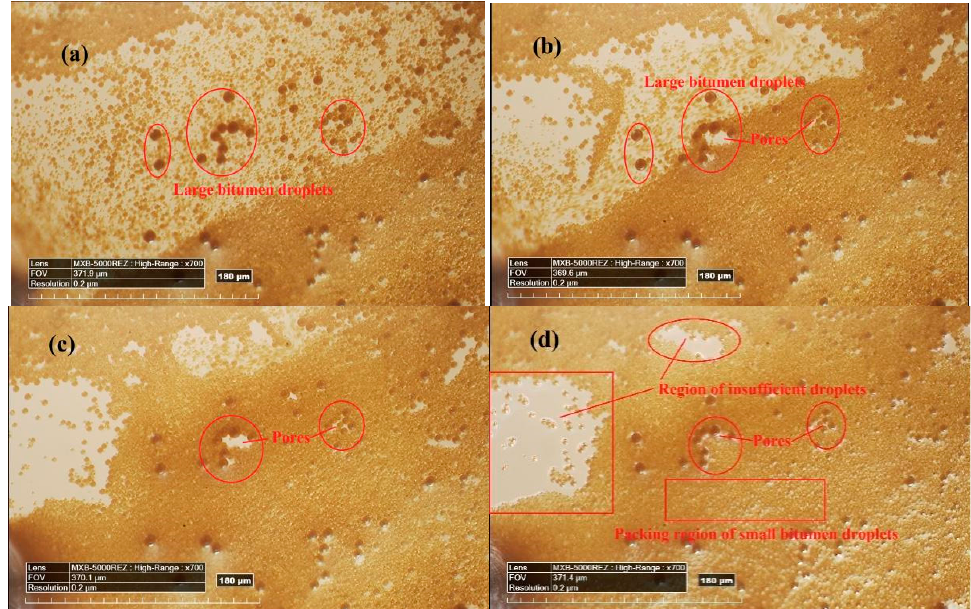
Figure 11. Evolution process of bitumen droplets packing during drying. ( a ) Most of droplets are well dispersed and water is enough; ( b ) Droplets packing begin in water- deficient region; ( c ) Large droplets can affect the small droplets packing during droplets packing; ( d ) Final droplets packing state with little free